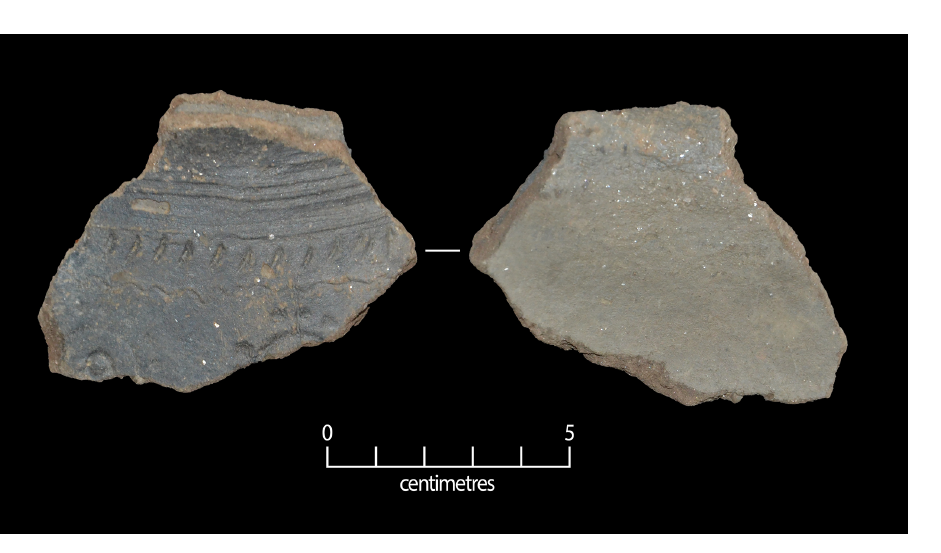
Figure 20: External surfaces of a Class 5 variant 7 potsherd, with decoration on external